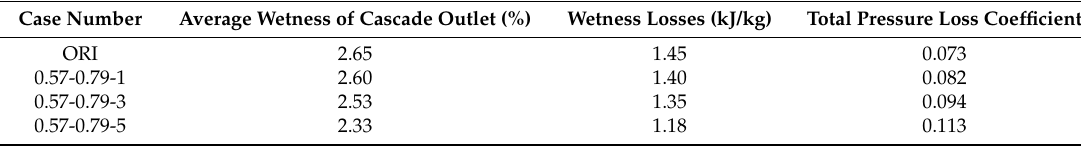
Table 3. Parameters of three